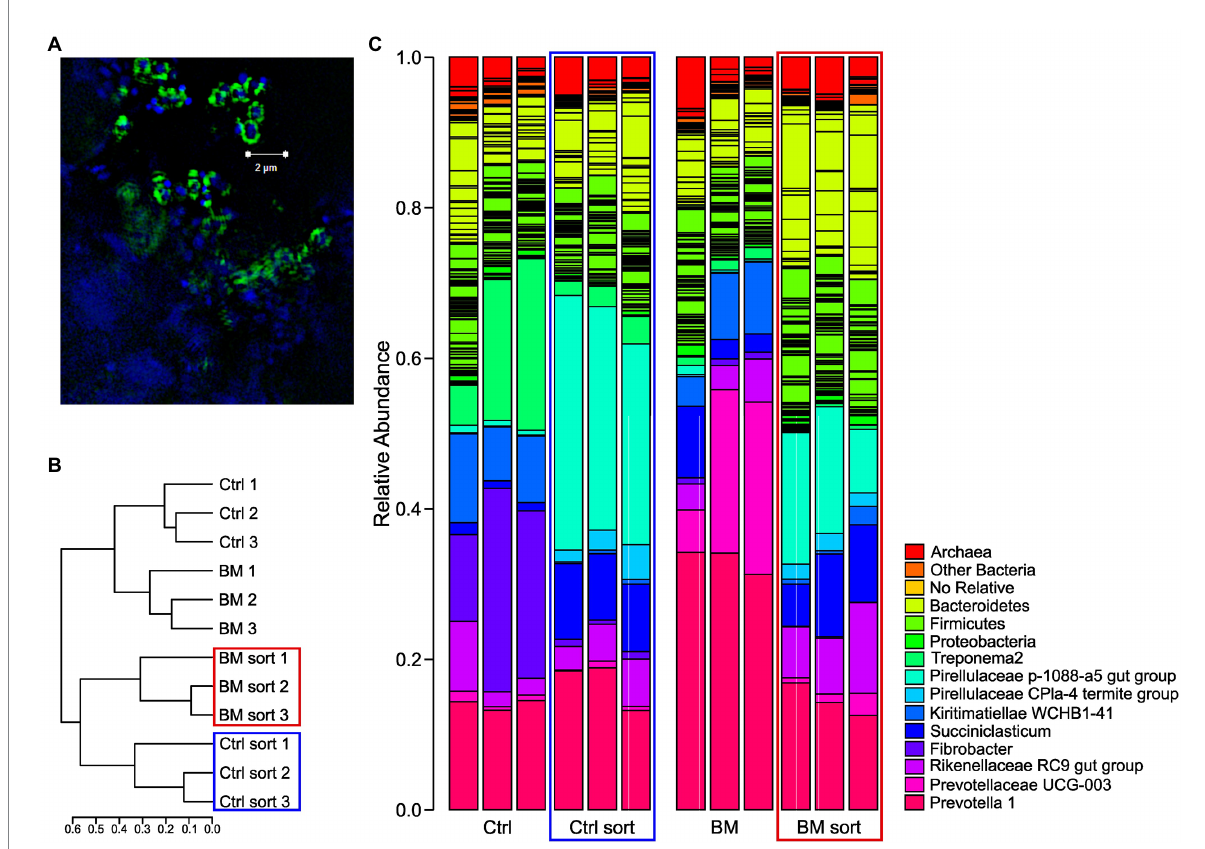
FIGURE 1 16S rRNA results of rumen communities ± Bio-Mos® before (unsorted) and after (sorted) FACS of FLA-YM incubated communities. (A) SR-SIM image of rumen community stained with DAPI (blue) and incubated with FLA-YM (green). (B) Phylogenetic tree of sorted and unsorted communities. (C) Relative abundance of taxonomic groups in each community. Unsorted control diet = Ctrl, sorted control diet = Ctrl Sort (blue box), unsorted Bio-Mos® diet = BM, and sorted Bio-Mos® diet = BM sort (red